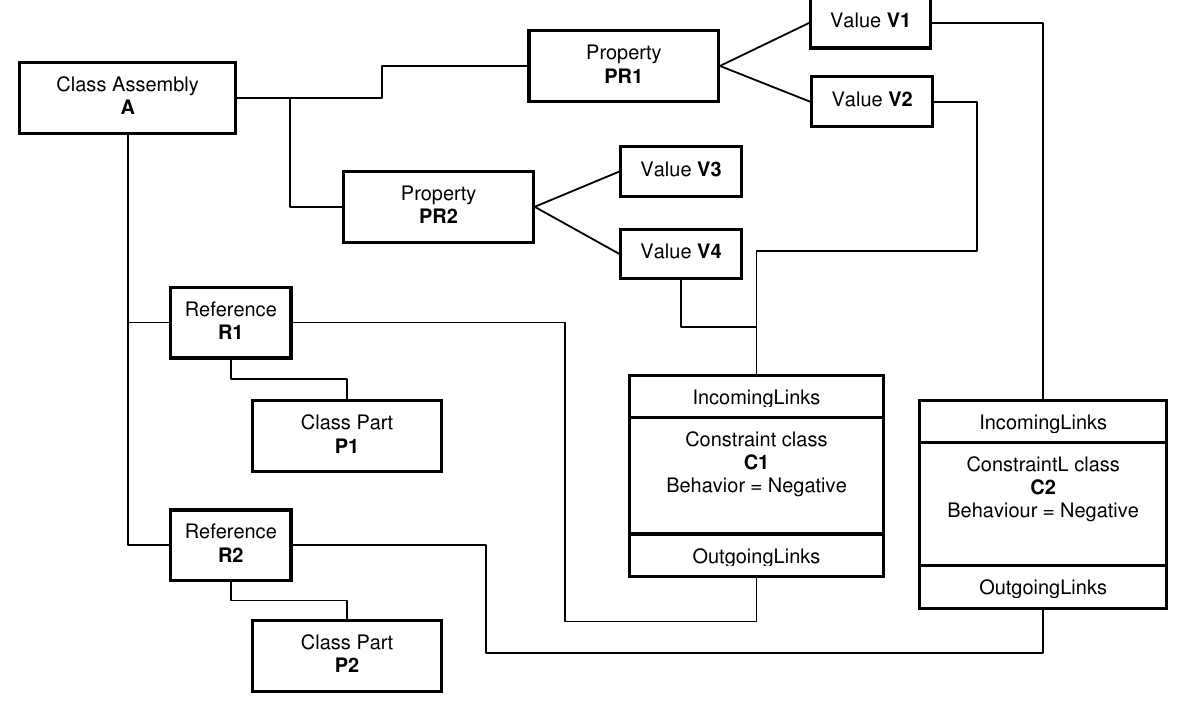
Fig 3. Usage of constraint